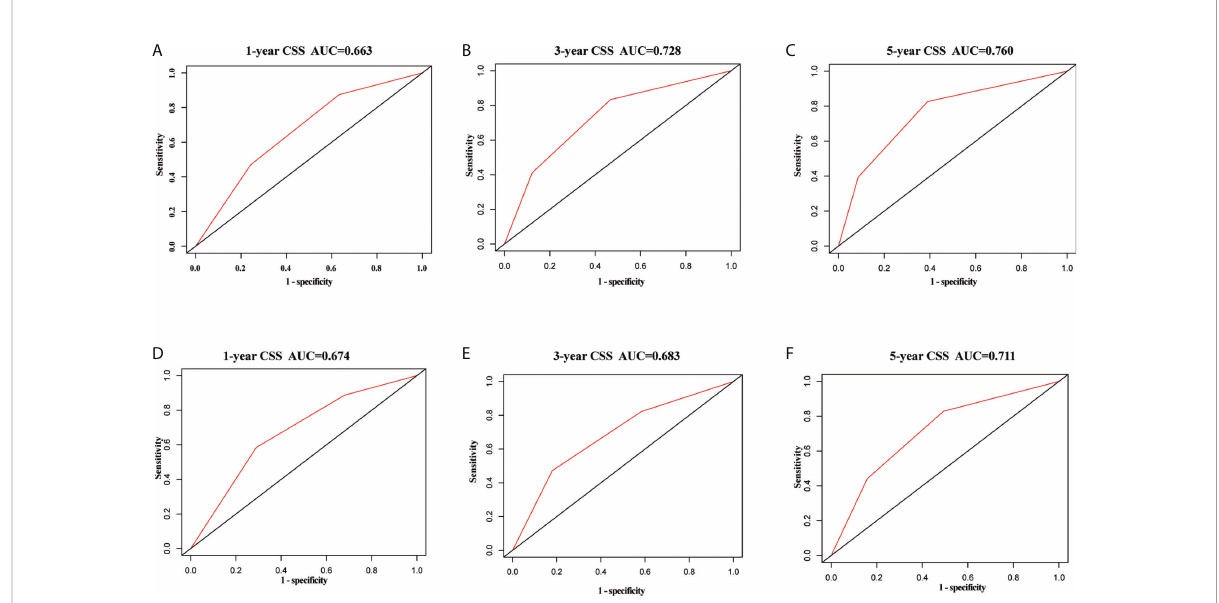
FIGURE 3 ROC curves of the nomogram for predicting cancer-speci fi c survival in surgically treated early-onset pancreatic cancer patients. ROC curves of the nomogram predicting CSS for 1-year (A) , 3-year (B) , and 5-year (C) in the training set; ROC curves of the nomogram predicting CSS for 1- year (D) , 3-year (E) , and 5-year (F) in the validation set. ROC, receiver operating characteristic; CSS, cancer-speci fi c survival.